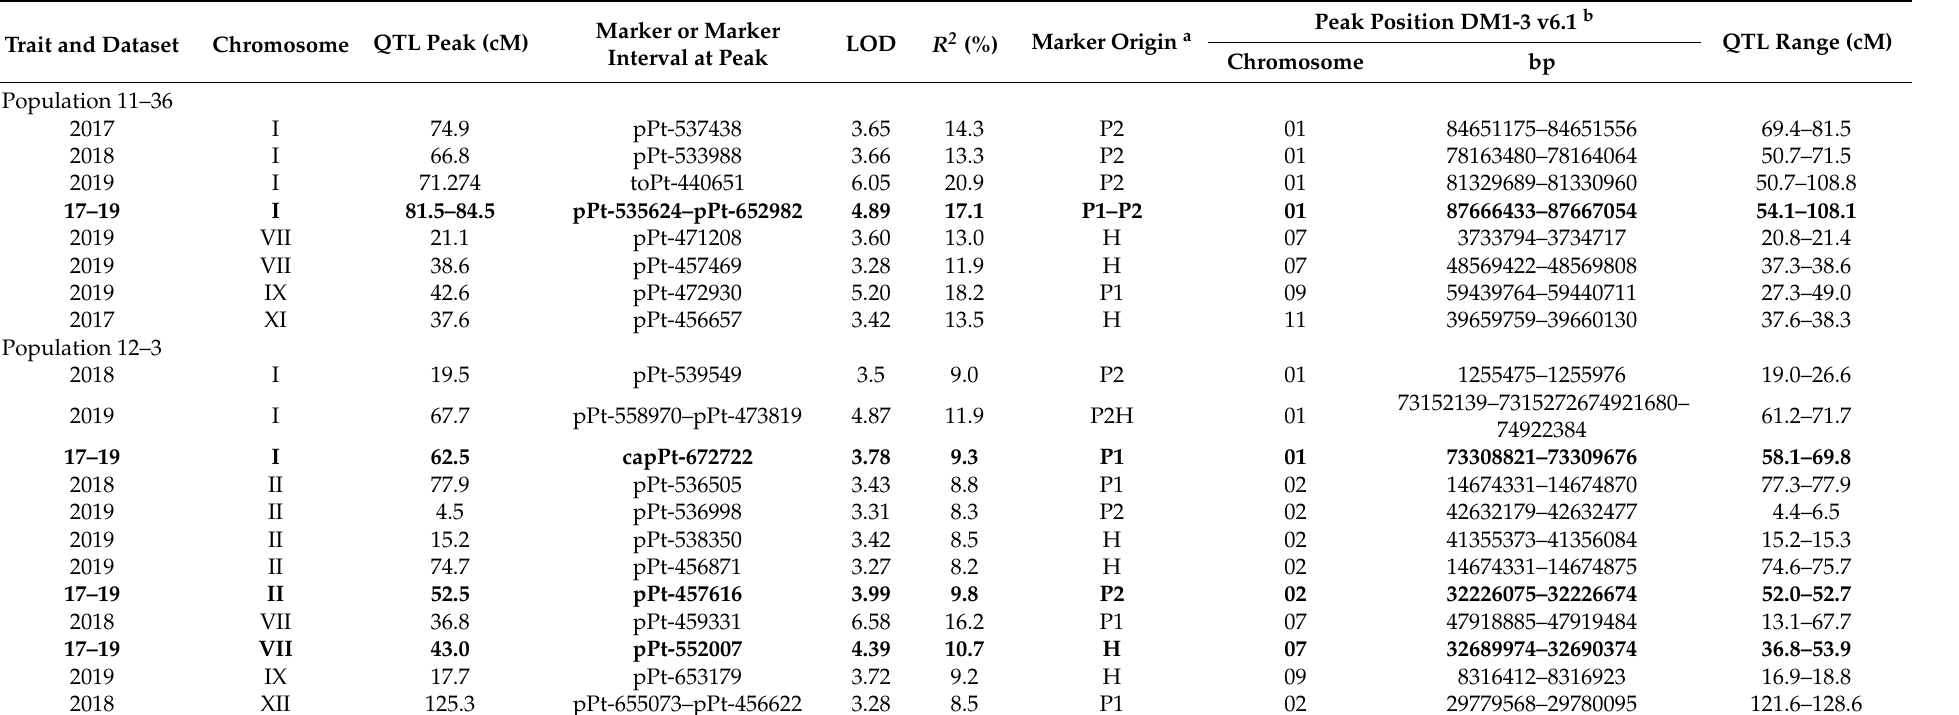
Table 3. QTL for dry rot resistance detected by interval mapping in datasets from the individual years of phenotypic assessments (2017–2019) and in the